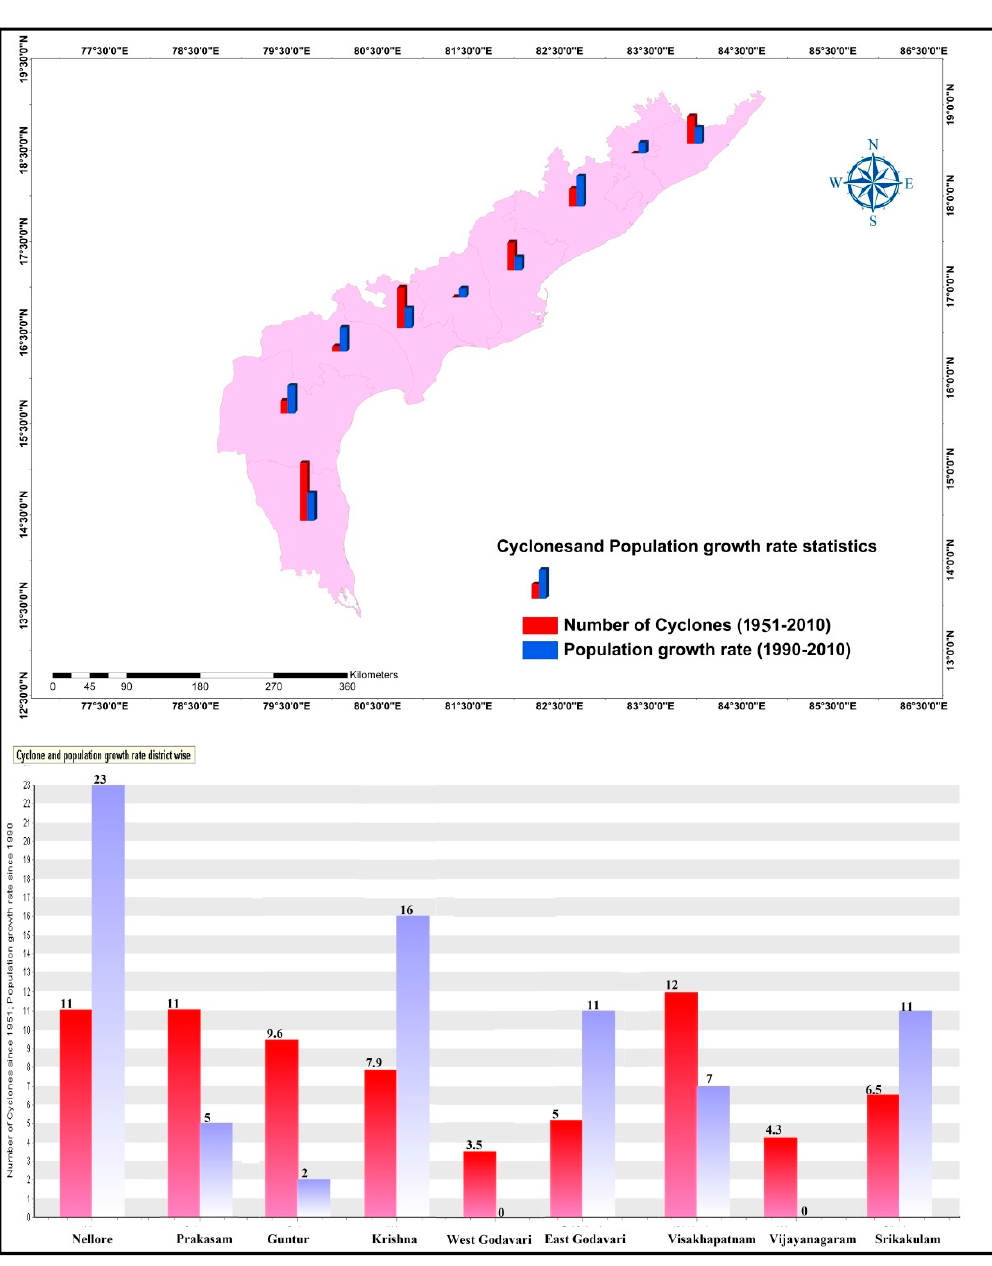
Figure 2. Total number of cyclones and population growth rate. Developed based upon the statistics of Revenue Disaster Management Andhra Pradesh (2017) [71].